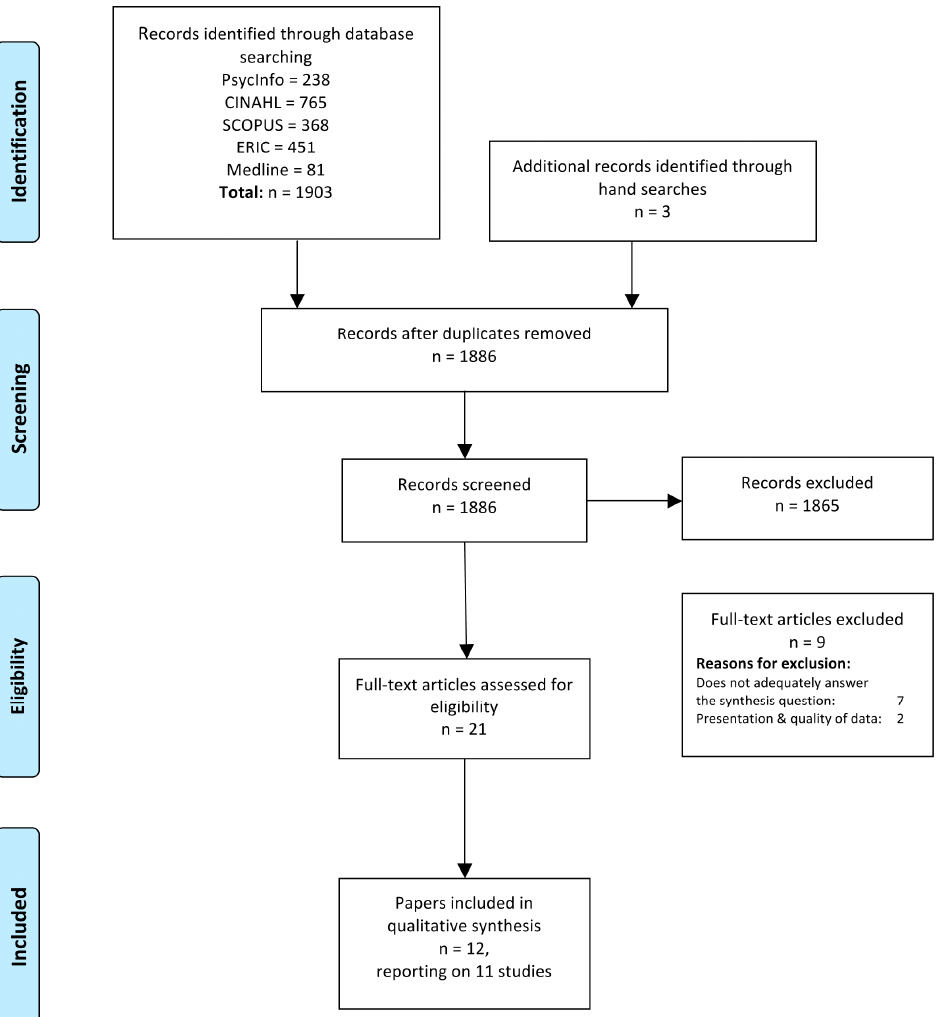
Figure 1. PRISMA flow diagram of the selection process. Adapted from the Preferred Reporting Items for Systematic Review and Meta-analyses (PRISMA) flow diagram [36].